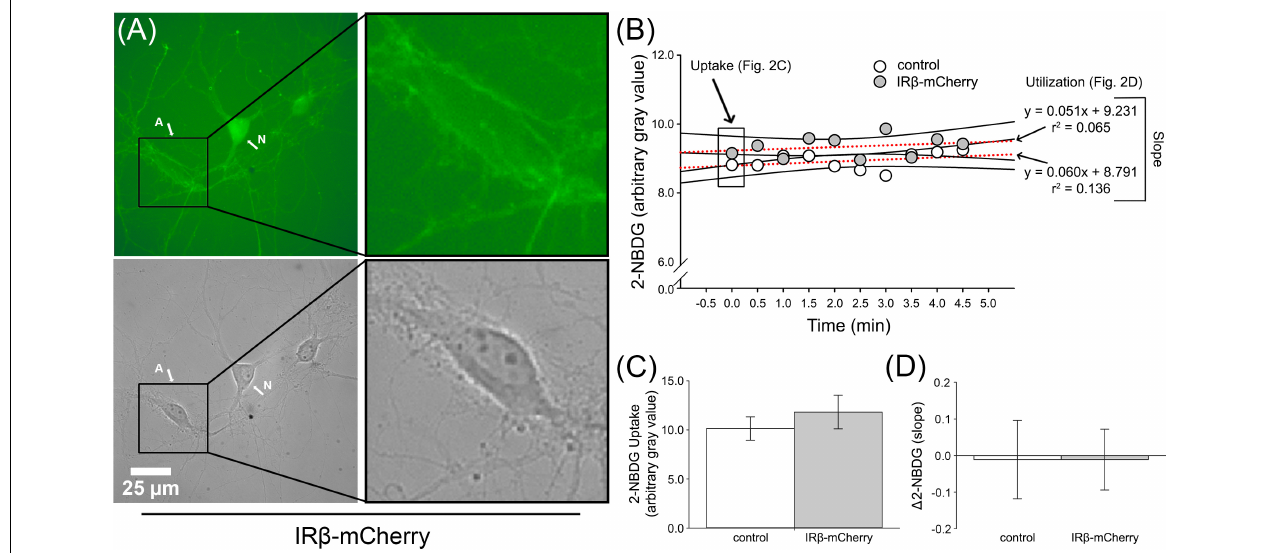
FIGURE 2 | 2-NBDG imaging of primary hippocampal astrocytes from dishes with or without IR β -expressing neurons. (A) Representative 2-NBDG fluorescent (top) and phase (bottom) photomicrographs obtained from a single IR β -expressing hippocampal culture dish. The letter A indicates a distinct astrocyte. The letter N indicates a distinct neuron. Right panels provide greater detail of astrocyte morphology and highlight the visual reduction in 2-NBDG fluorescent signal in this cell compared to the neighboring neuron. (B) Data obtained from representative astrocytes from a control or IR β -treated dish during 2-NBDG imaging. Boxed data at time point 0.0 indicate initial gray value used for 2-NBDG uptake analysis. Dashed red lines represent examples of the linear regressions used for (cid:49) 2-NBDG calculation (slope). (C) Quantification of background-subtracted 2-NBDG uptake in hippocampal astrocytes from dishes with ( n = 12 dishes) or without ( n = 13 dishes) IR β expression. No significant changes in 2-NBDG uptake values were observed between control and IR β dishes (Student’s t -test, p > 0.05). (D) Quantification of background-subtracted (cid:49) 2-NBDG as indirect measures of 2-NBDG utilization rates in astrocytes. No significant difference in rates of 2-NBDG utilization were noted between control and IR β dishes (Student’s t -test, p > 0.05). All data represent means ± SEM.